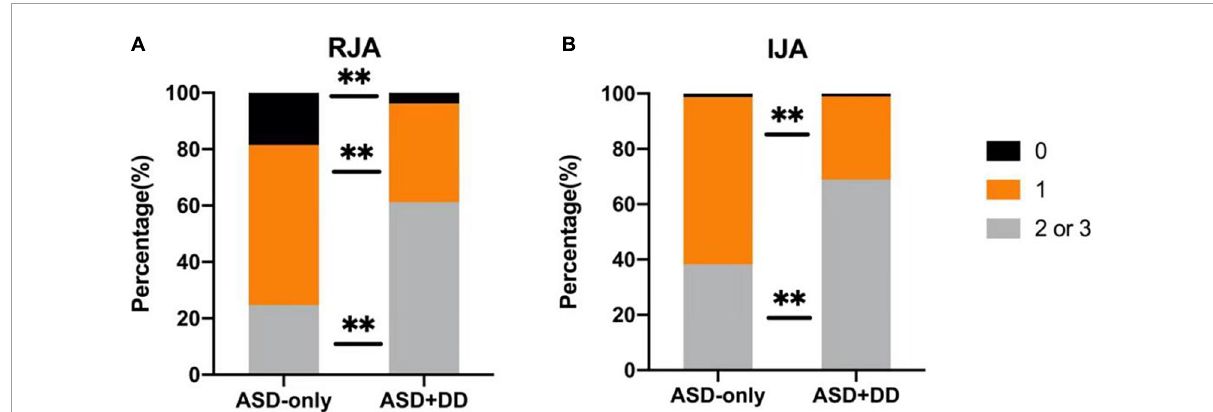
FIGURE1 Comparisons of responding to joint attention (RJA) and initiating joint attention (IJA) ability between autism spectrum disorder (ASD) patients with and without developmental delay (DD). (A) and (B) represent the percentages of RJA and IJA scores. Comparisons between the two groups were performed using an analysis of variance. Different colors represent different scores. Black indicates an alerting score of 0, orange a score of 1, and gray a score of 2 or 3. ** p <